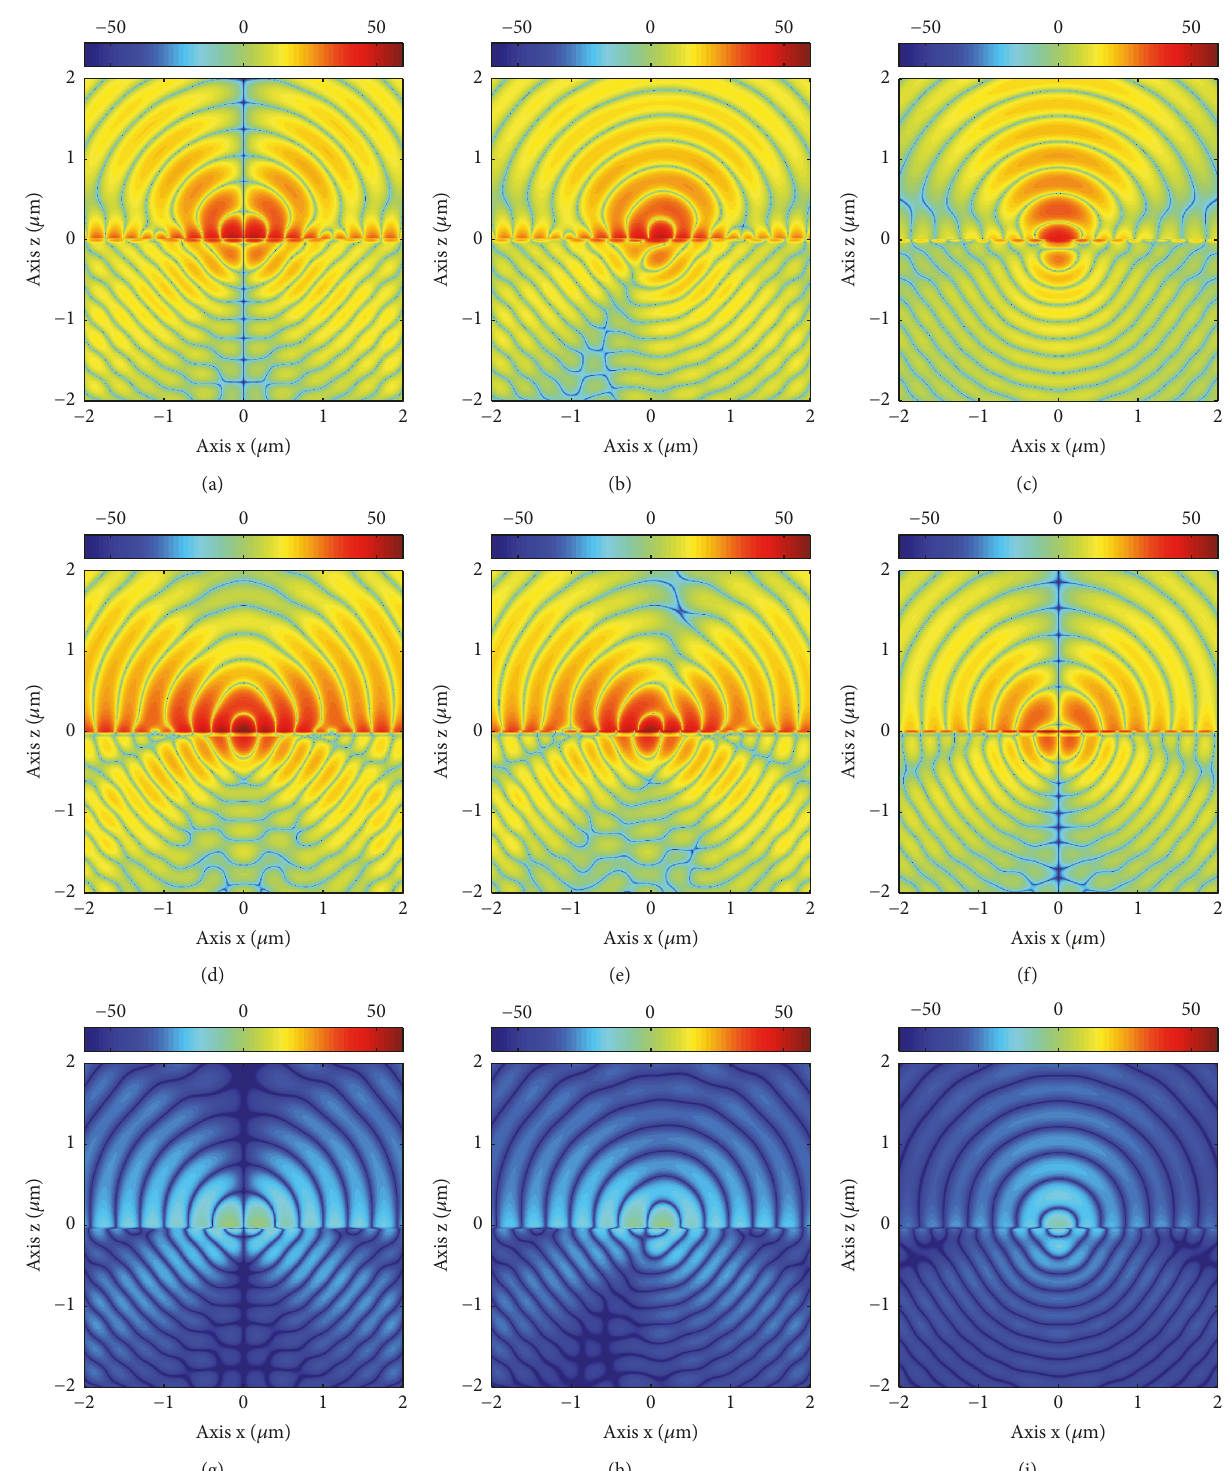
Figure 10: Electric and Magnetic Field. 20 log | Re {𝐸𝑥}| : (a) 𝜃 󸀠 = 0 ∘ , (b) 𝜃 󸀠 = 45 ∘ , and (c) 𝜃 󸀠 = 90 ∘ ; 20 log | Re {𝐸𝑧}| : (d) 𝜃 󸀠 = 0 ∘ , (e) 𝜃 󸀠 = 45 ∘ , and (f) 𝜃 󸀠 = 90 ∘ ; 20 log | Re {𝐻𝑦}| : (g) 𝜃 󸀠 = 0 ∘ , (h) 𝜃 󸀠 = 45 ∘ , and (i) 𝜃 󸀠 = 90 ∘ . In these results we set the following: 𝛿 𝑔 = 50𝑛𝑚 , ℎ = 20𝑛𝑚 , Δ = 10𝜇𝑚 , 𝜆 = 632.8𝑛𝑚 , and 𝜙 󸀠 = 0 ∘ 𝑐